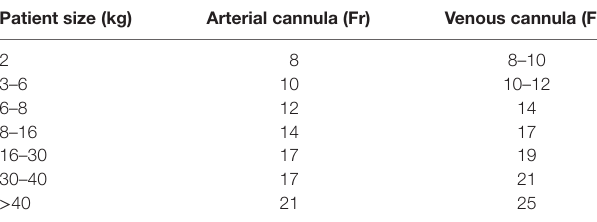
TAbLe 1 | Cannula size (Fr) by patient weight.